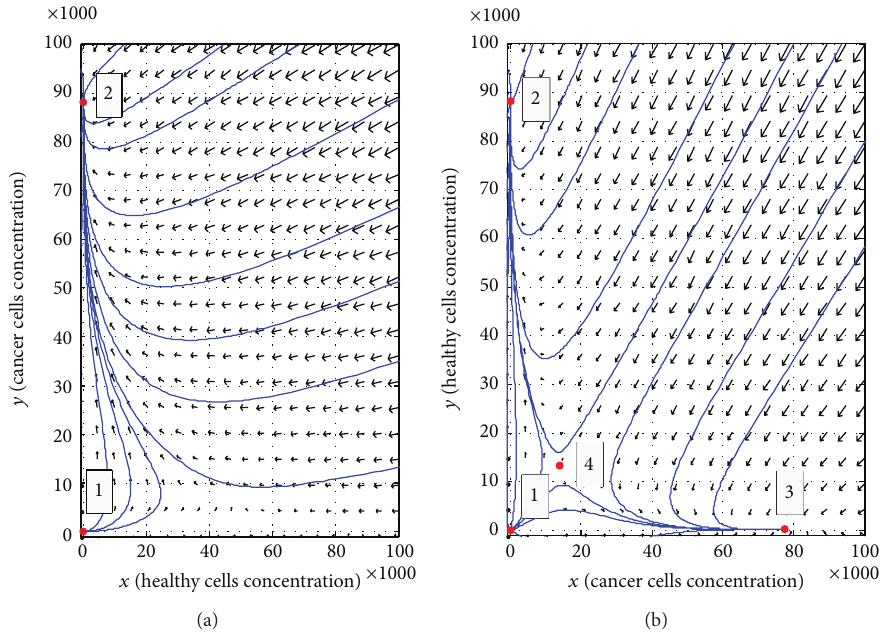
Figure 1: The trajectory pattern of the free system: (a) before the vaccination and (b) after the vaccination.